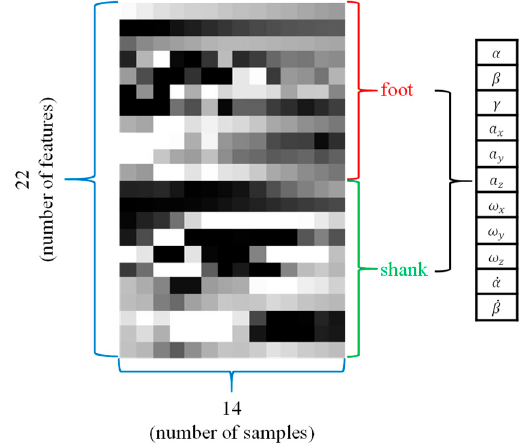
Figure 17. Sample input image.